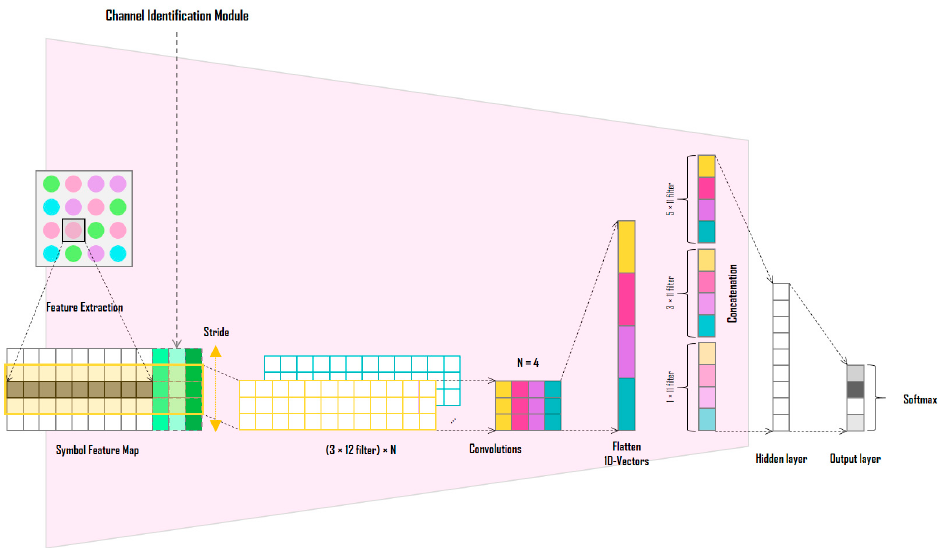
Figure 3. Structure of the symbol decision module.